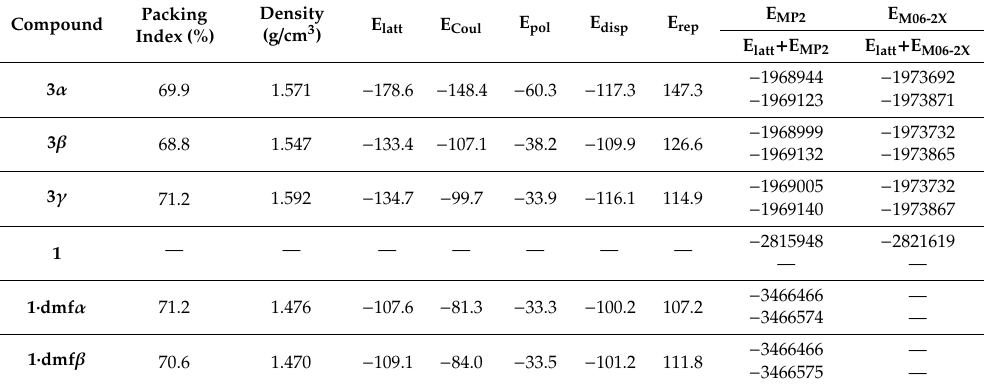
Table 2. The packing index and density values derived from structural data. E latt is the calculated total lattice energy (as − ∆ H of sublimation) and its components. E MP2 is the Hartree–Fock energy with the inclusion of the Møller–Plesset correlation energy correction calculated for the atom positions taken from x-ray coordinates registered at room temperature after optimization of the hydrogen atoms positions. E M06-2X is the energy calculated with the M06-2X density functional with optimization of whole molecule geometry. Energy values are in kJ /